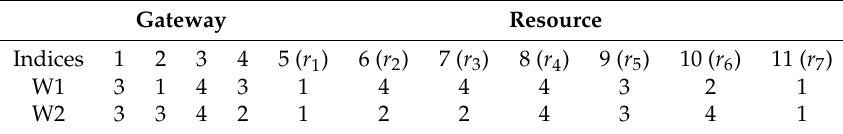
Table 3. The distance between two